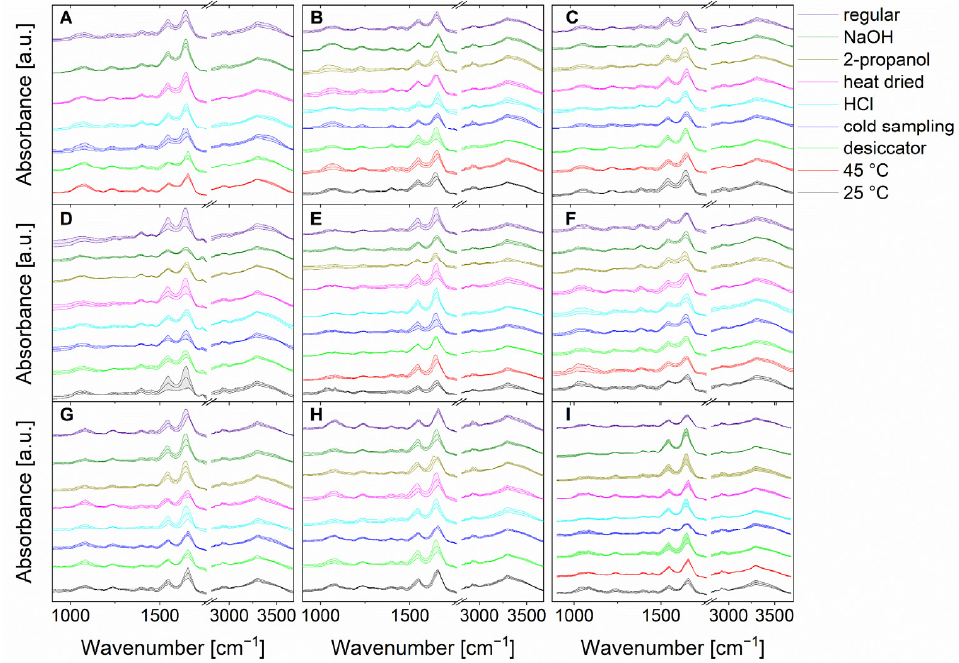
Figure 2. Stacked mean IR spectra of the normalized data of in total 15,200 spectra (200 spectra of each stress condition and regular treatment) of B. coag ( A ), B. sub ( B ), B. therm ( C ), B. tii ( D ), E. coli K12 ( E ), M. luteus ( F ), Ps. fluor 4358 ( G ), Ps. fluor 50090 ( H ) and E. coli TOP10 ( I ). Standard deviations are indicated by color-coded bands around the mean value.